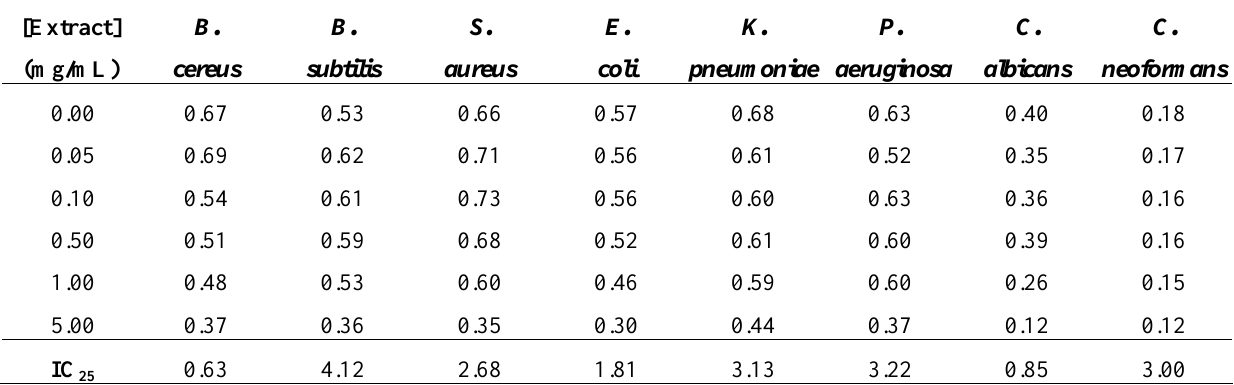
Table 2. Values for microbial growth rate in the presence of different olive leaf extract concentrations and IC 25